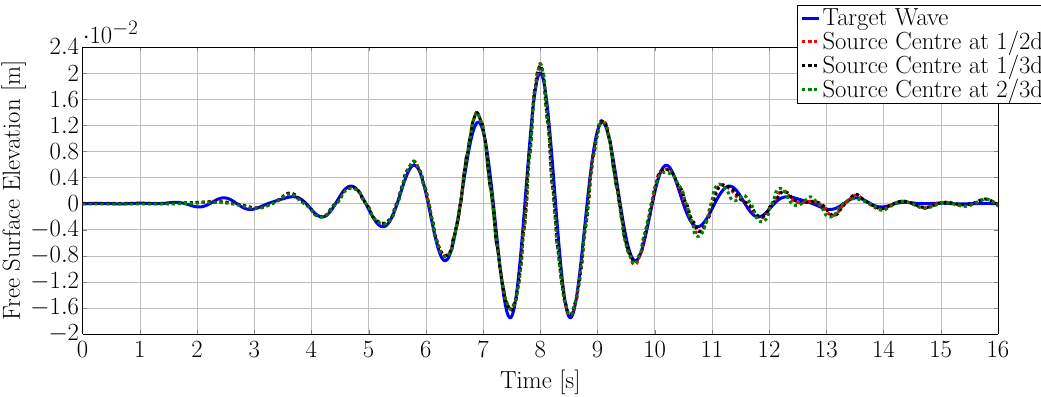
Figure 10. Surface elevation time series for intermediate water experiments that produced the best results for the three different source centre locations.